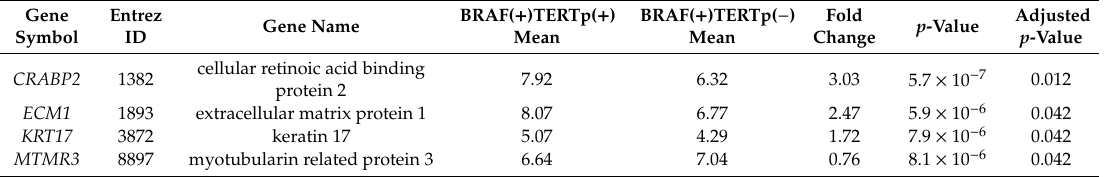
Table 3. Genes di ff erentiating BRAF( + )TERTp( + ) PTCs and BRAF( + )TERTp( − )